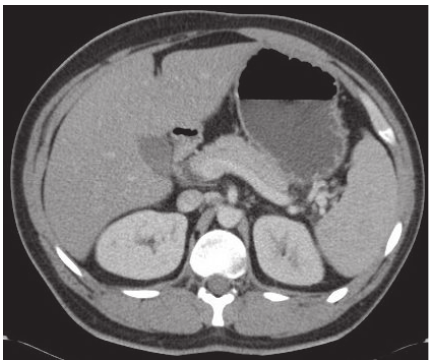
Figure 1: A coronal section of the contrast computed tomography scan, revealing a fatty liver and normal